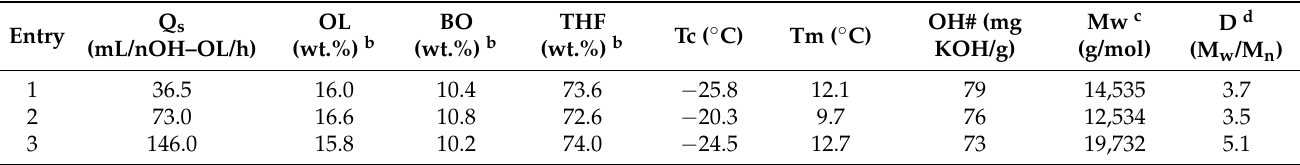
Table 4. Effect of the oxirane specific addition flow rate (Q s ) on the LBP microstructure a